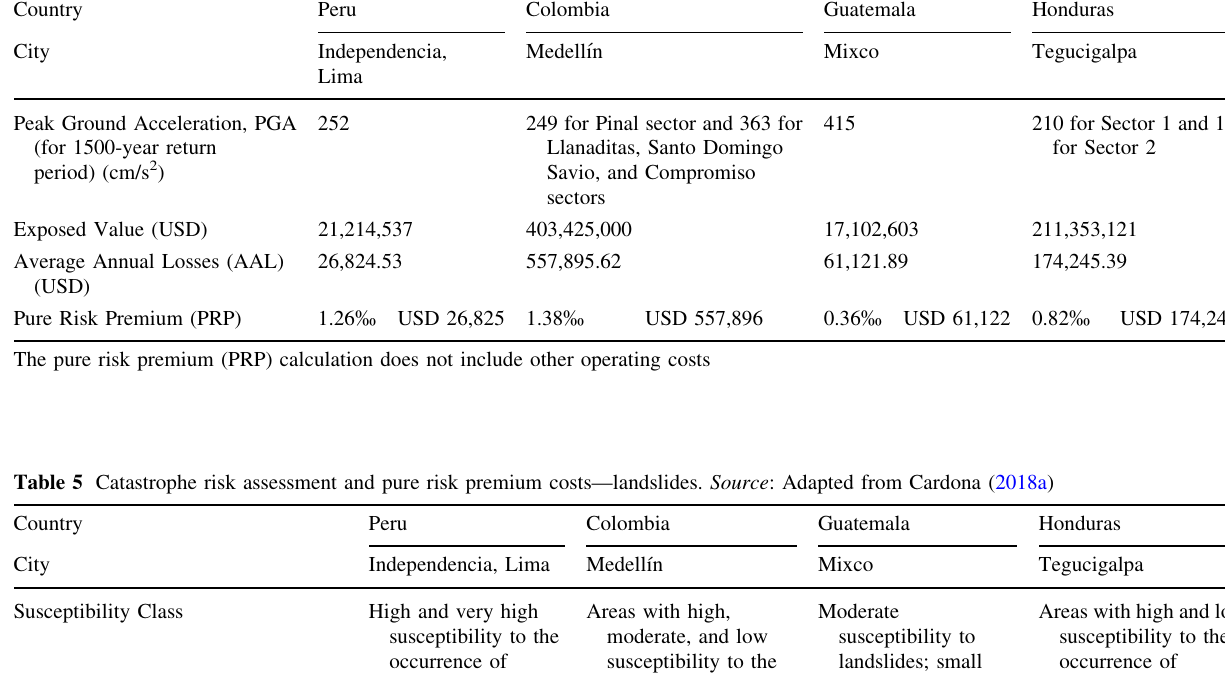
Peak Ground Acceleration, PGA (for 1500-year return